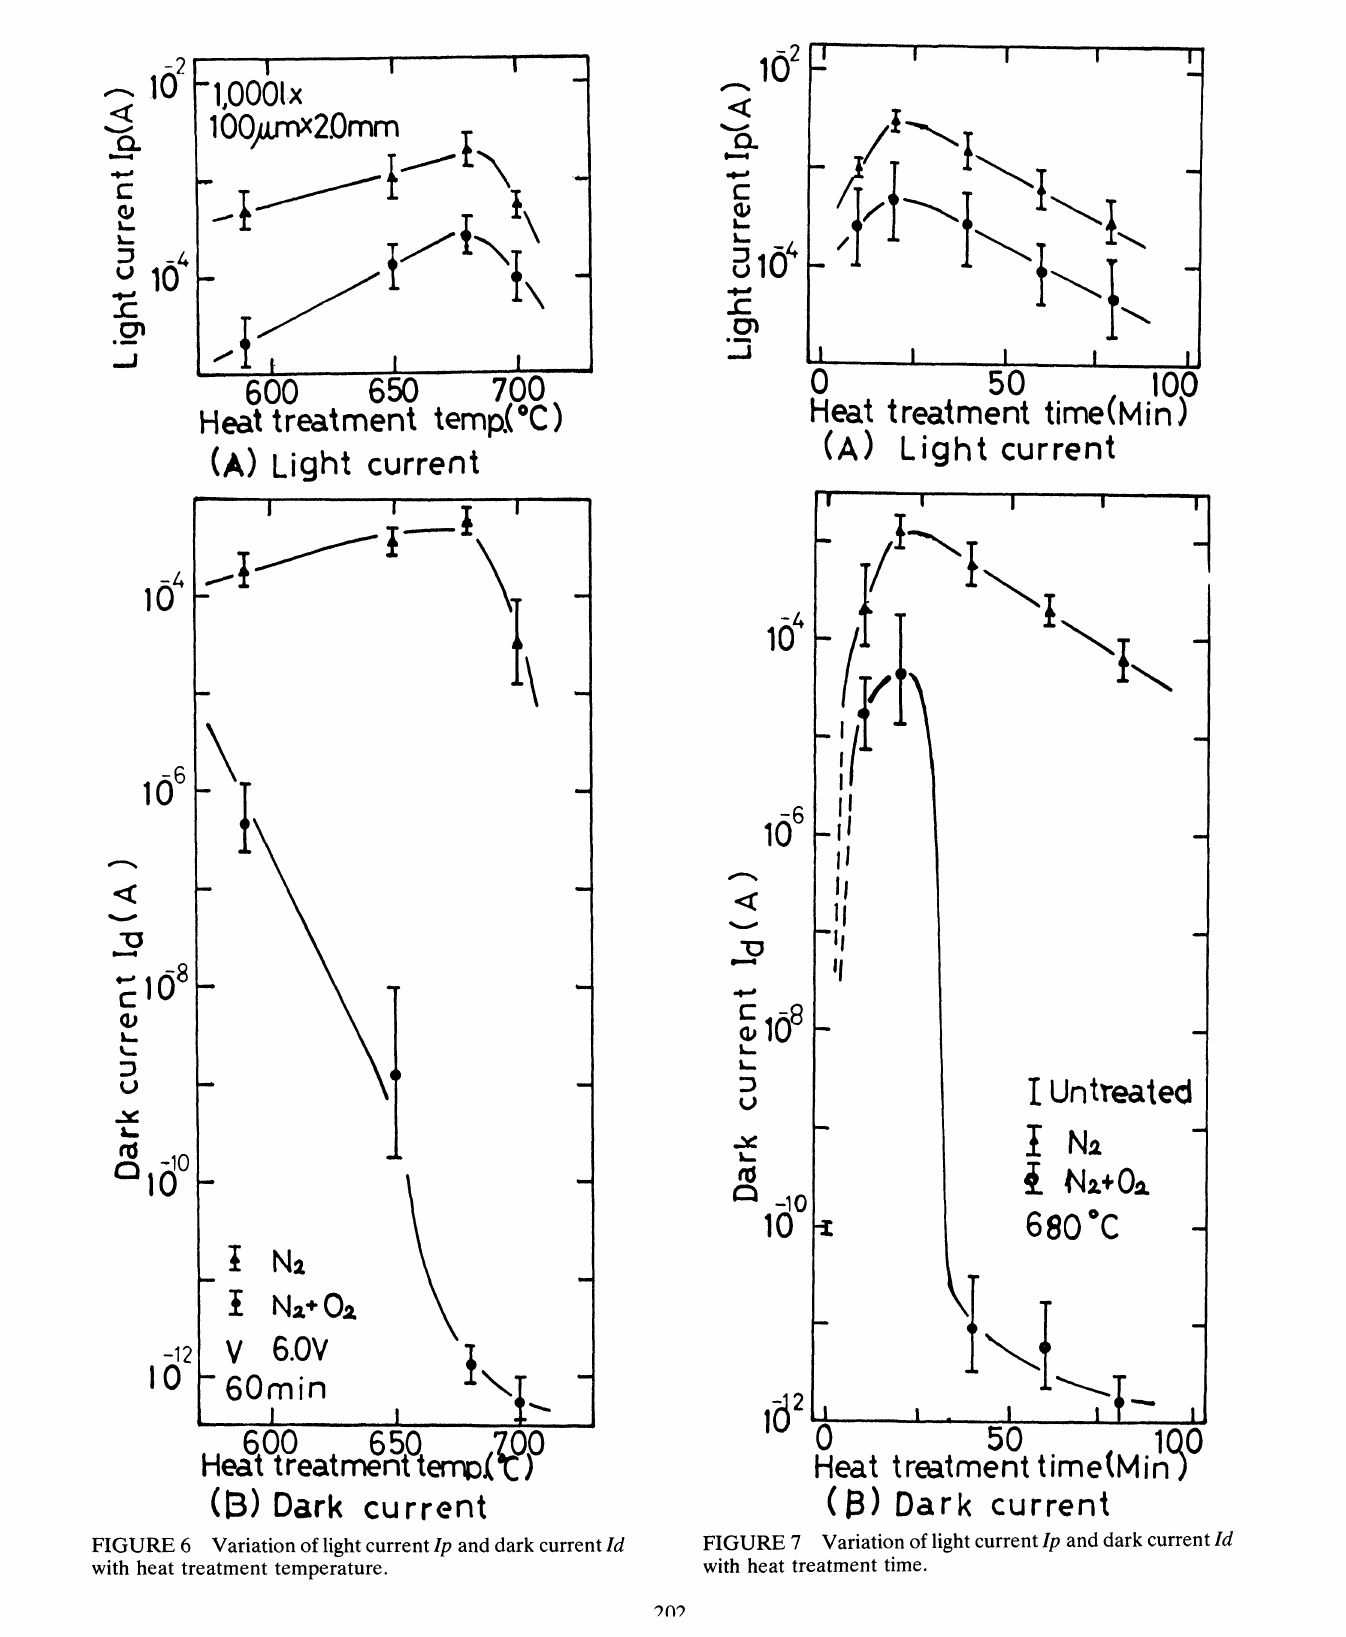
FIGURE 6 Variation of light current Ip and dark current Id with heat treatment temperature.